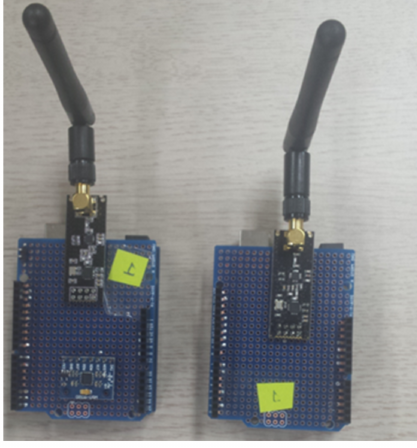
Figure 4. Data collection module ( left : transmitter; right :